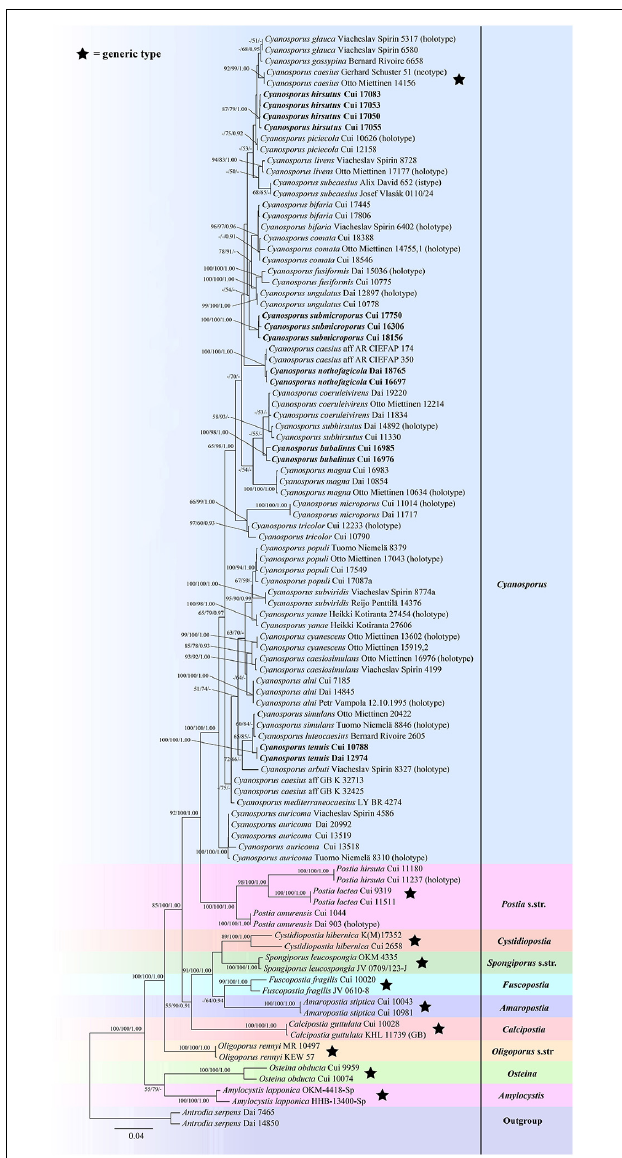
FIGURE 3 | Maximum likelihood tree illustrating the phylogeny of Cyanosporus and its related genera in the antrodia clade based on the combined sequences dataset of ITS + nLSU + nSSU + mtSSU + RPB1 + RPB2 + TEF. Branches are labeled with maximum likelihood bootstrap higher than 50%, parsimony bootstrap proportions higher than 50% and Bayesian posterior probabilities more than 0.90 respectively. Bold names = New